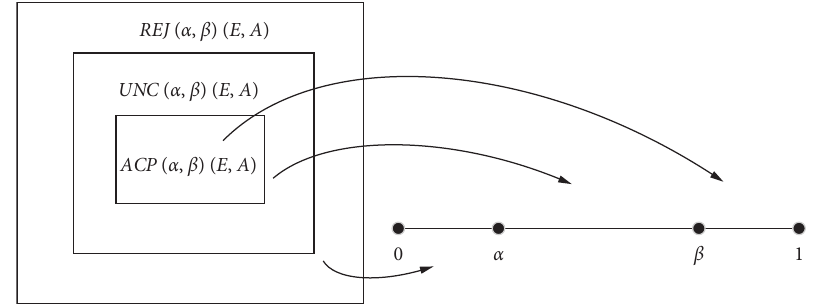
Figure 2: Three regions divided by